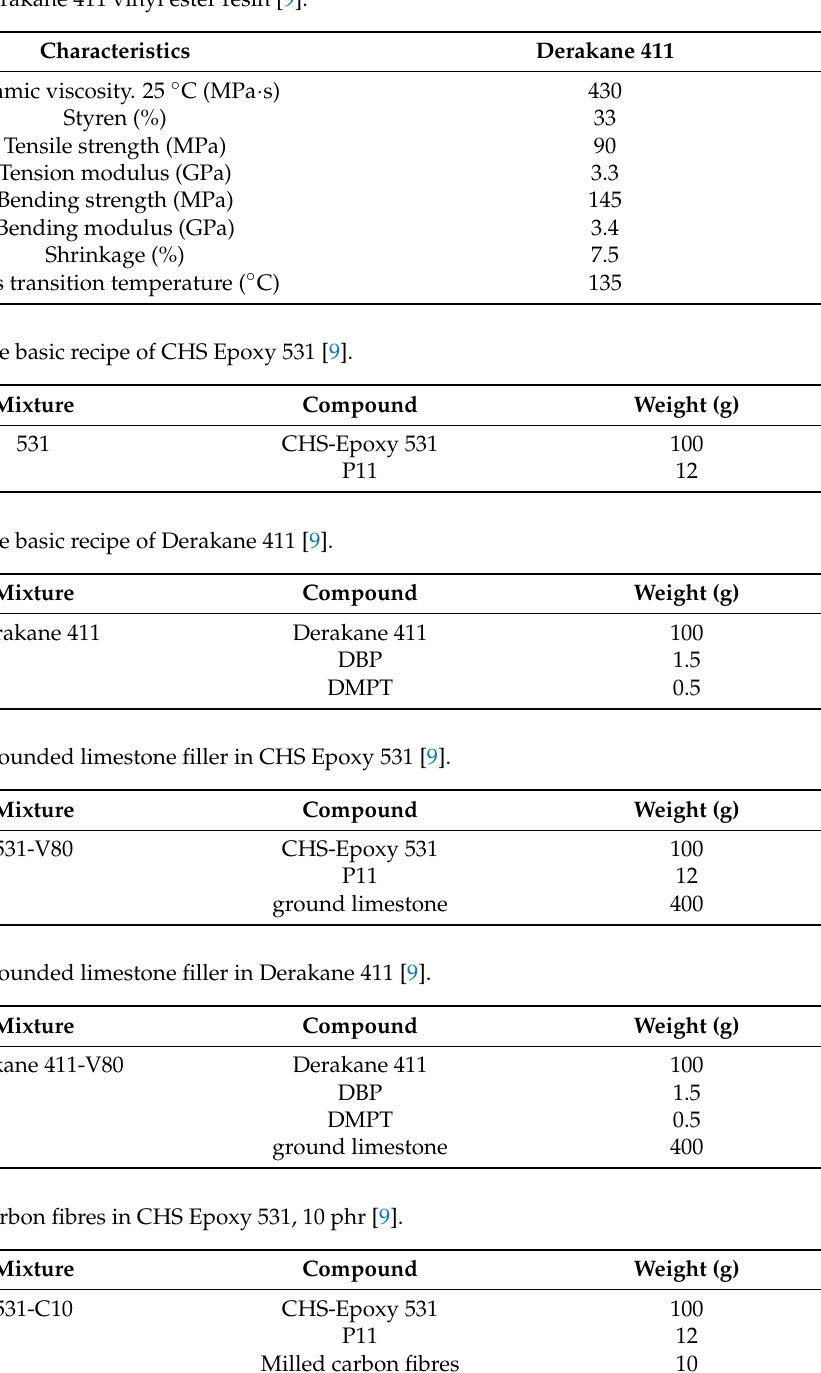
Table A2. Derakane 411 vinyl ester resin [9].